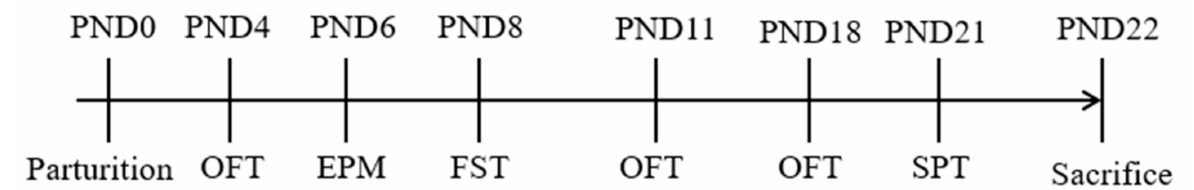
Figure 2. Schedule of behavioral tests. OFT, open field test; EPM, elevated plus maze test; FST, forced swim test; SPT, sucrose preference